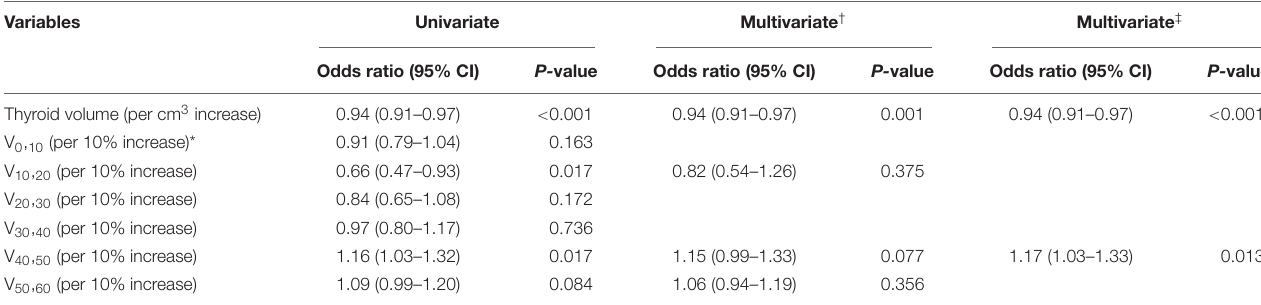
TABLE 2 | Results of logistic regression for the development of